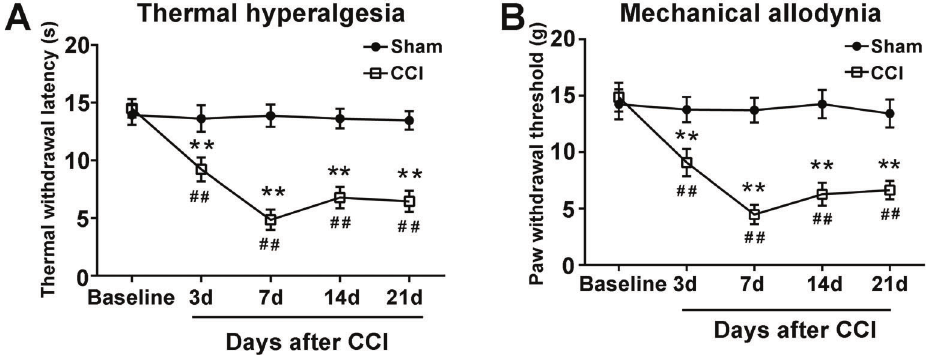
Figure 1. Behavioral testing of chronic constriction injury (CCI) rats. A , Duration of thermal withdrawal latency (F=61.487); B , paw withdrawal threshold (F=53.652). **P o 0.01 compared with sham group at the same time point; ## P o 0.01 compared with baseline, n=7 per group (ANOVA with repeated